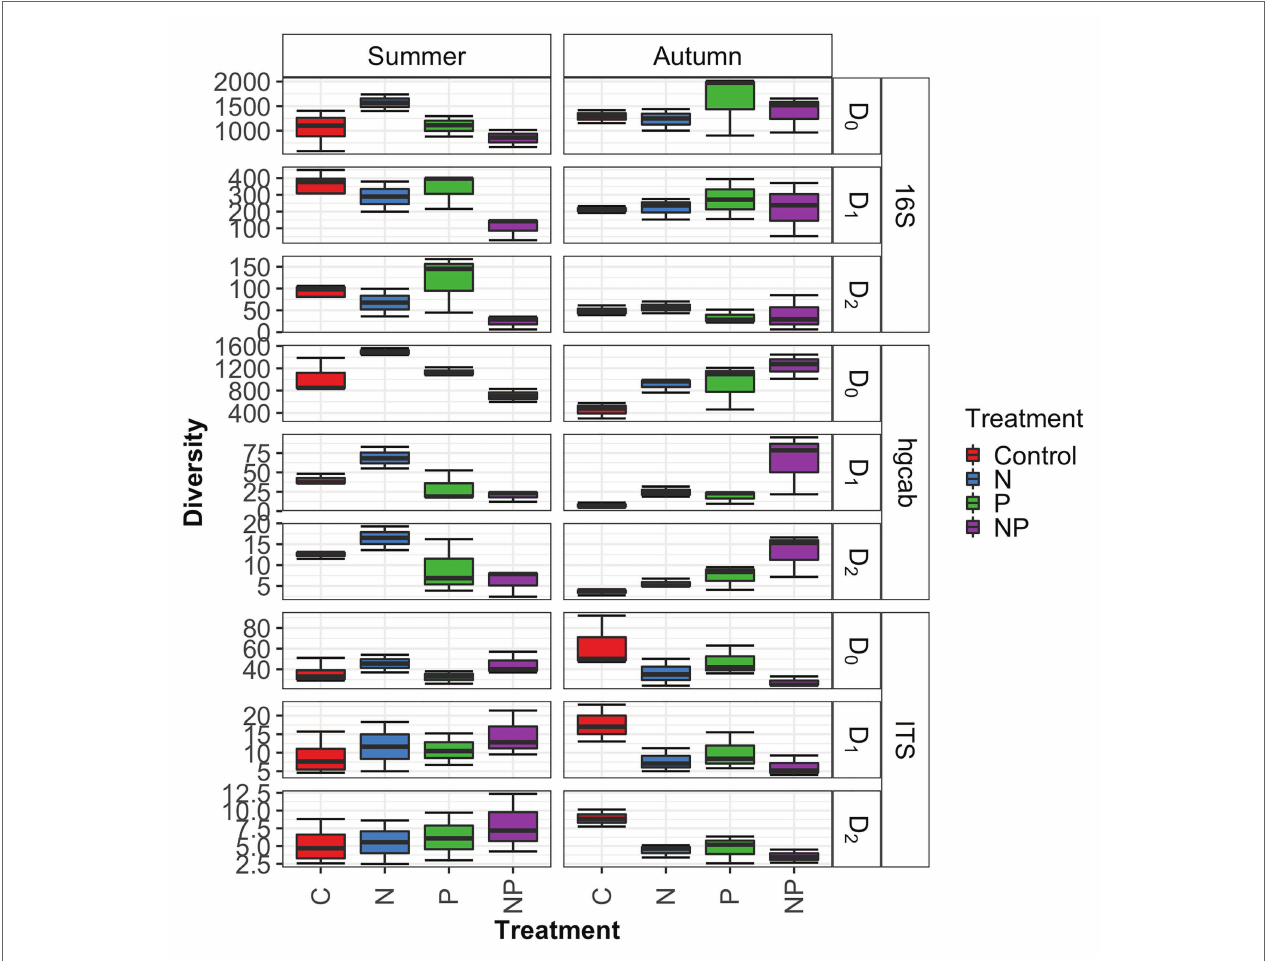
FIGURE 4 | Microbiome diversity across control, nitrate (N), phosphate (P), and nitrate + phosphate (NP) nutrient exposure treatments and summer and autumn seasons measured by Hill’s numbers.